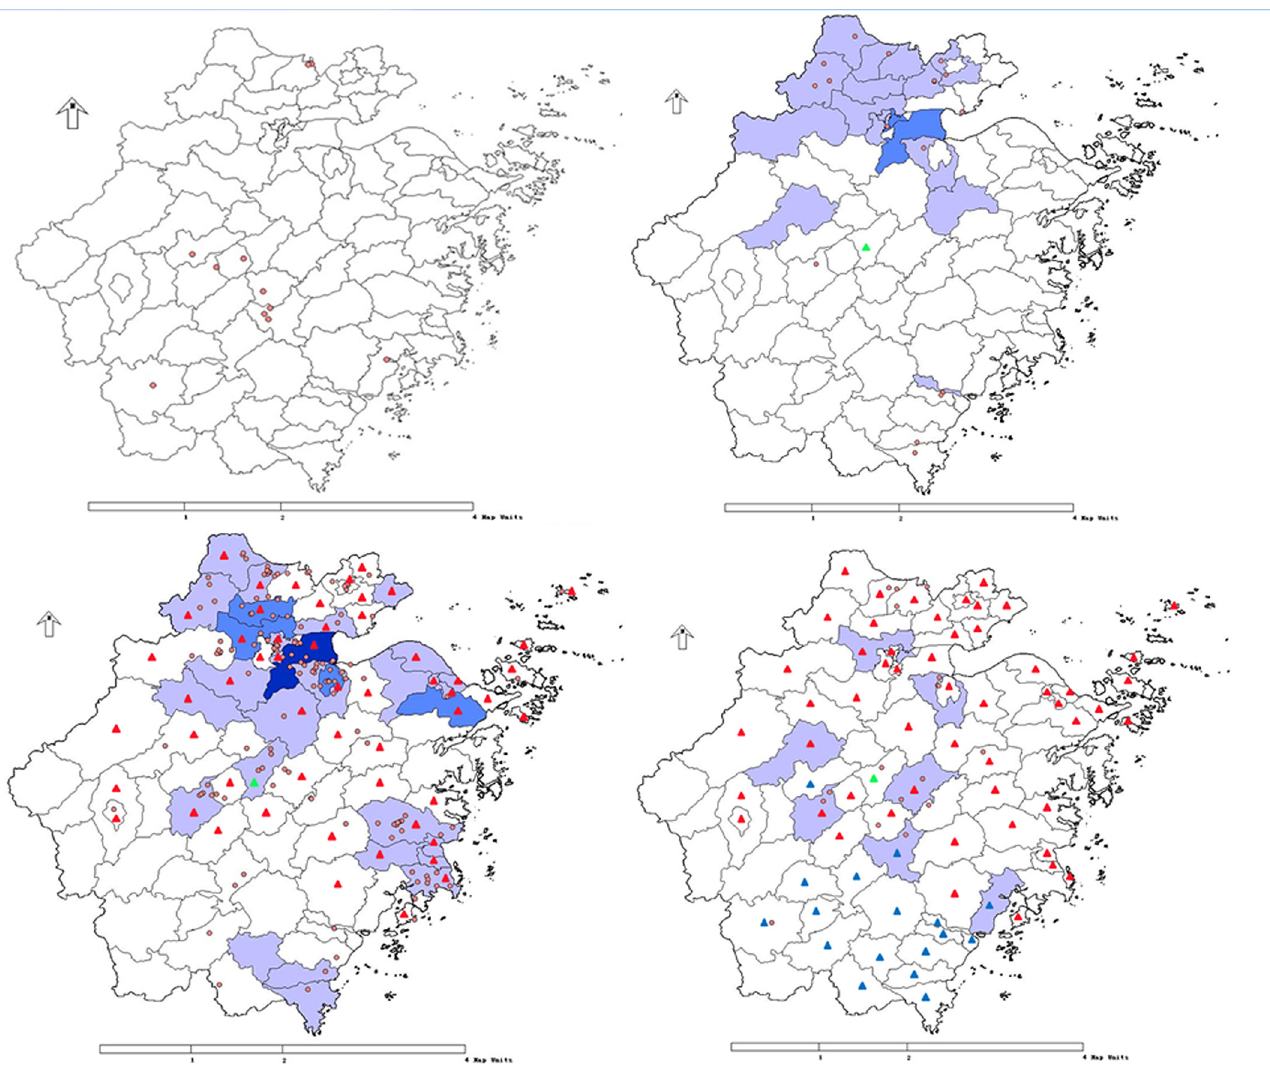
Fig 2. Geographical distribution of H7N9 positive samples and confirmed cases in 2013(upper left), January(upper right), February(lower left) and March(lower right), 2014 Red circle: The sampling site with positive H7N9 virus Red triangle: Counties with live poultry markets closed at the end of January, 2014 Blue triangle: Counties with live poultry markets closed in February, 2014 Green triangle: Counties with live poultry markets closed in July, 2013 Light blue:Counties with 1~5 cases confirmed Blue:Counties with 5~10 cases confirmed Dark blue:Counties with > 10 cases